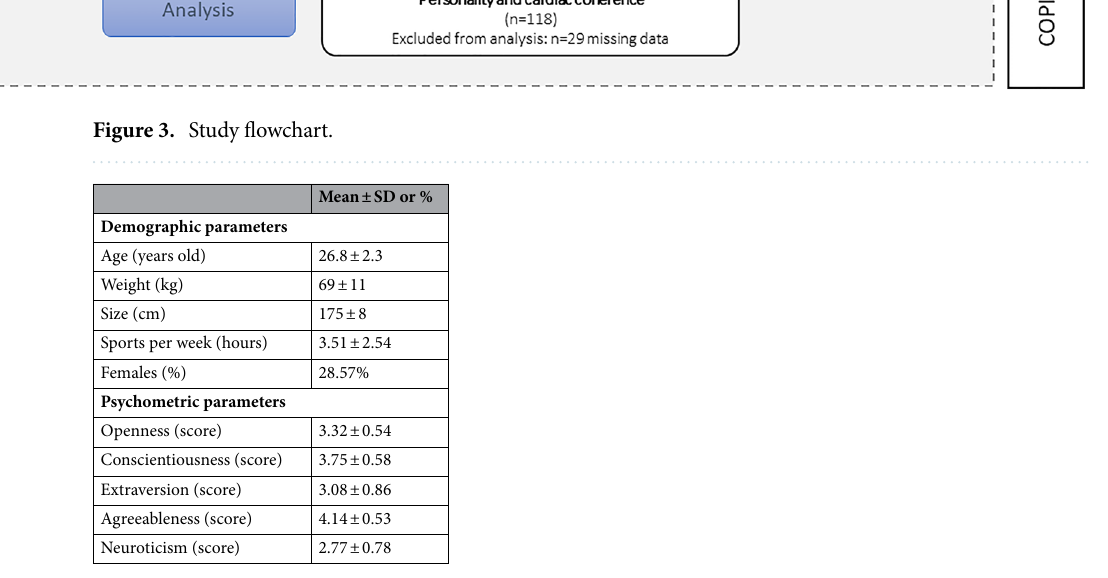
Table 2. Participants demographical and psychometric parameters (n =